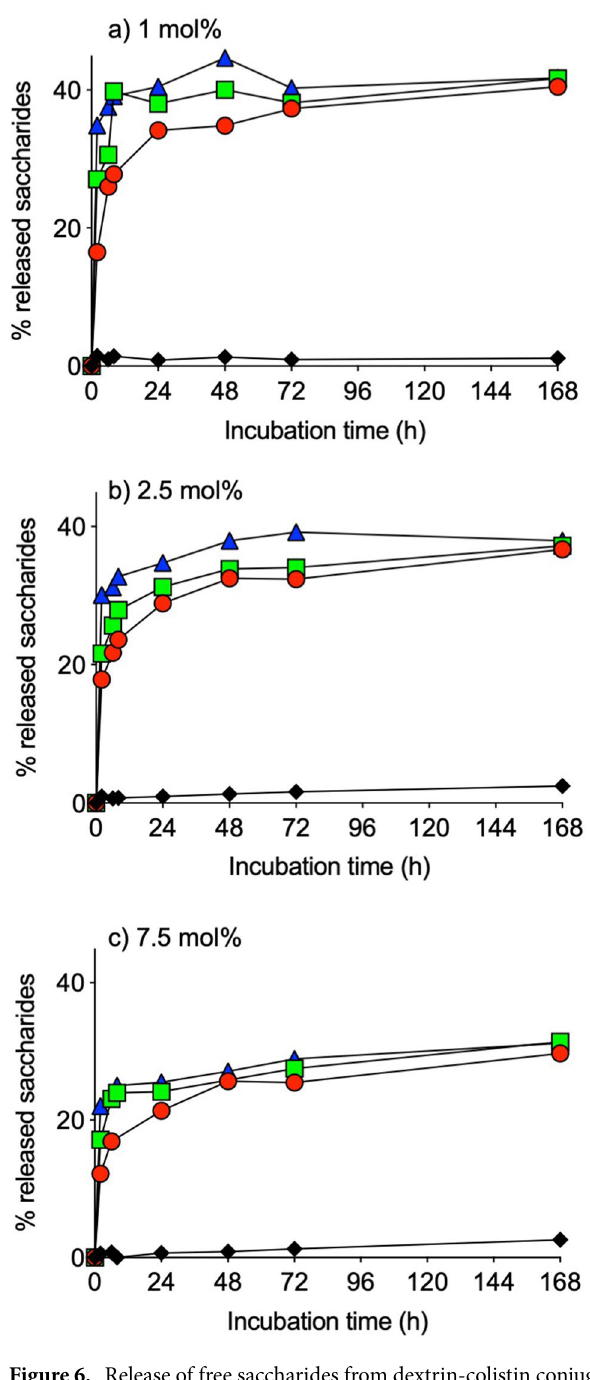
Figure 6. Release of free saccharides from dextrin-colistin conjugates with ( a ) 1 mol%, ( b ) 2.5 mol% and ( c ) 7.5 mol% succinoylation following incubation with amylase (0 (black diamond), 20 (red circle), 100 (green square) and 500 (dark blue triangle) IU/L) at 37 °C for up to 168